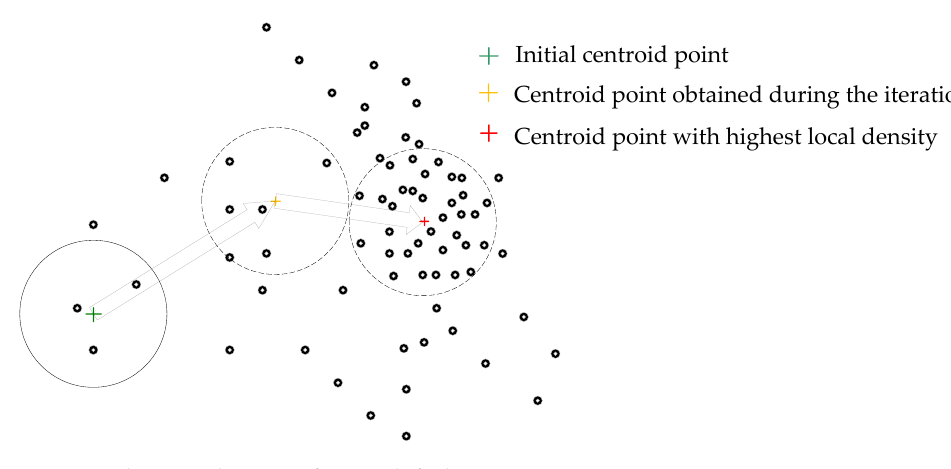
Figure 4. Schematic diagram of mean shift